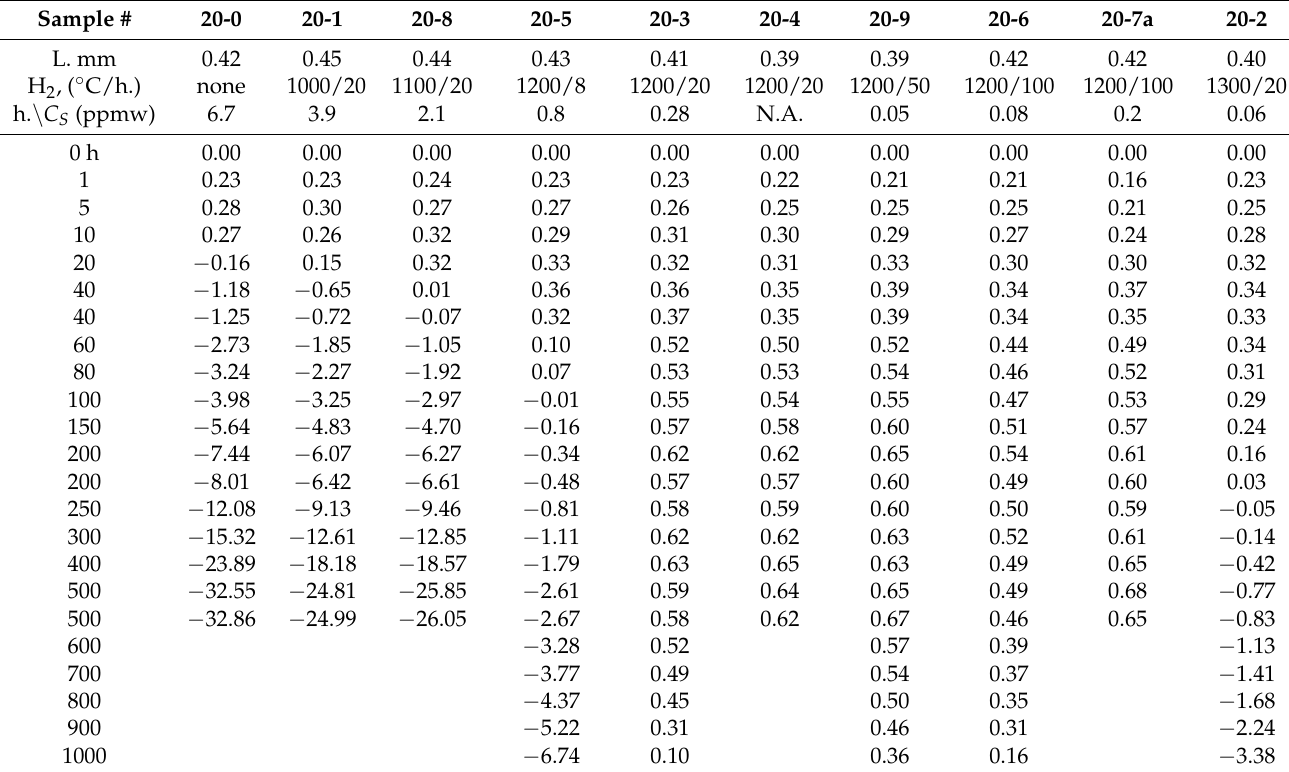
Table 2. Cyclic-oxidation specific weight change data for “20 mil” PWA 1480 samples (1100 ◦ C for 500 or 1000 h in air). Effect of hydrogen annealing time and temperature. Measured sulfur content ( C S ) after hydrogen annealing; thickness (L) measured after polishing and before oxidation testing.